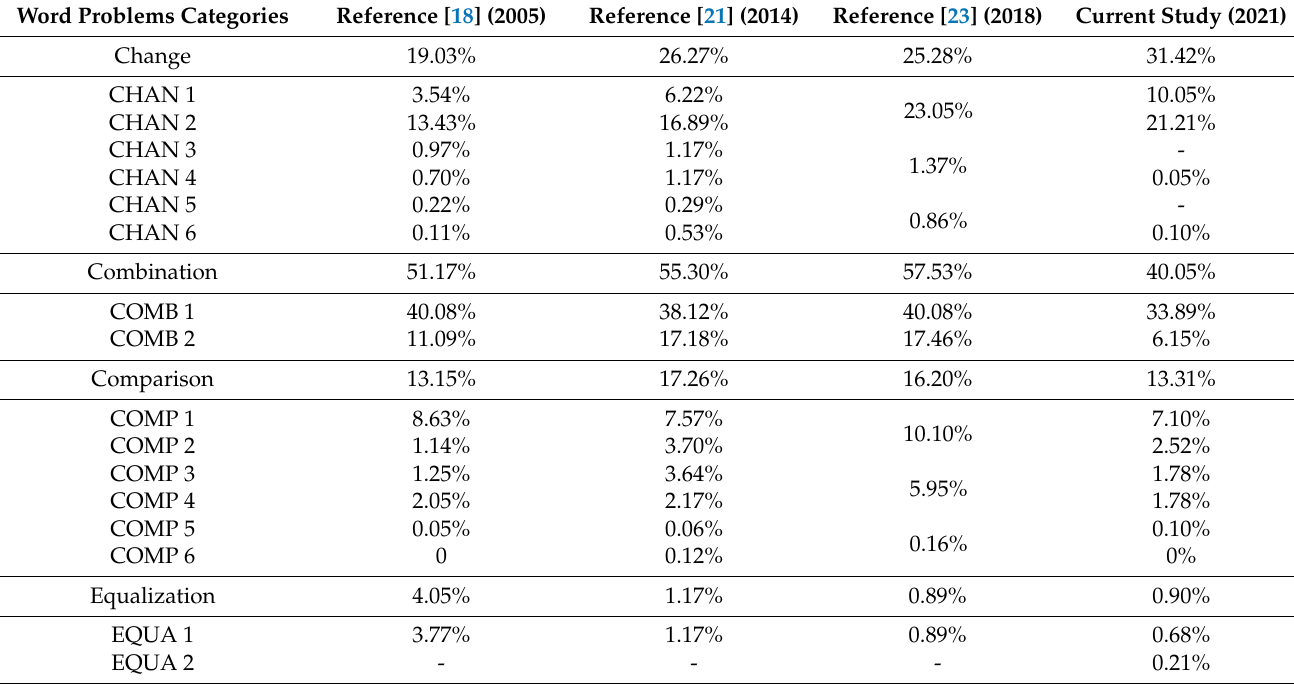
Table 5. Comparative analysis of the level of semantic-mathematical complexity of word problems with simple addi- tive structure.